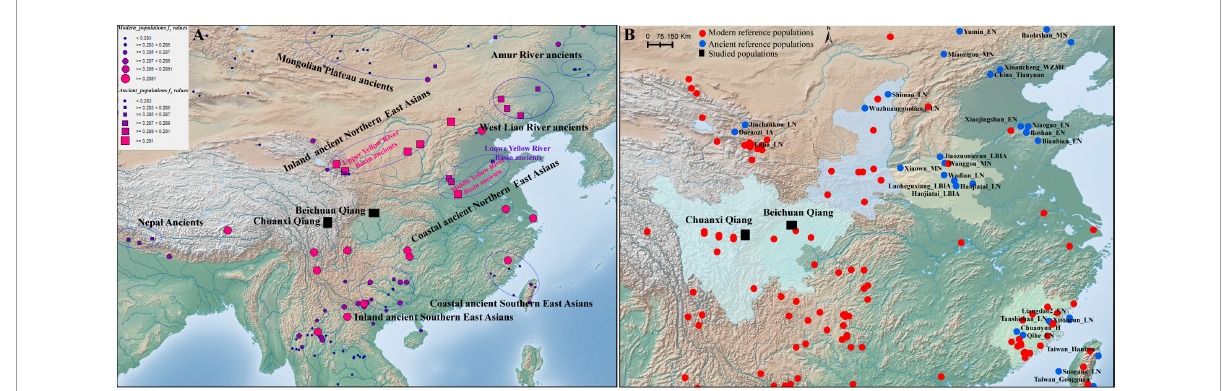
FIGURE1 Geographical positions of our studied populations and reference populations. (A) Genetic affinity between Chuanxi Qiang and reference populations from the HO dataset. The color and size of the circle showed the genetic affinity between the Qiang people and the modern reference populations, and the color and size of the square denote the genetic affinity with ancient reference populations. (B) Geographical position of the studied populations and reference populations from the Illumina